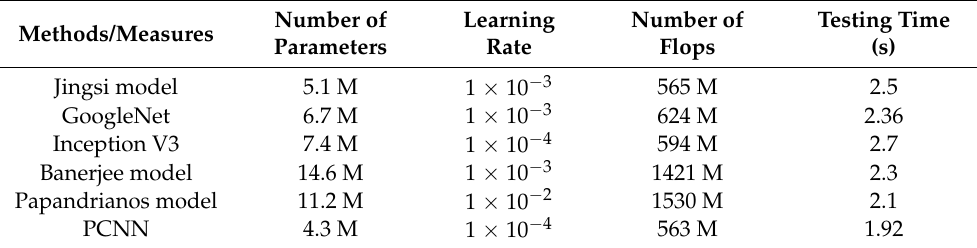
Figure 15. Receiver operating characteristic (ROC) and precision–recall curve: dataset_2. Table 11 highlights the computational complexities of CNN models for Dataset_1. It is evident from the outcome that PCNN requires a smaller number of parameters (4.3 M), learning rate (1 × 10 − 4 ), number of flops (563 M), and computation time (1.92 s). Table 11. Computational complexities of CNN for Dataset_1.